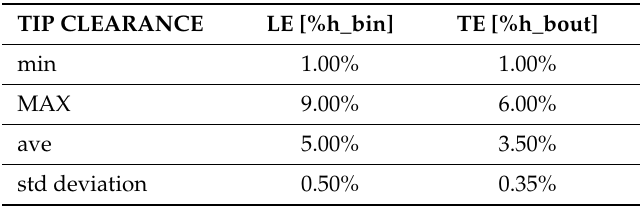
Table 2. Input uncertain variables range and